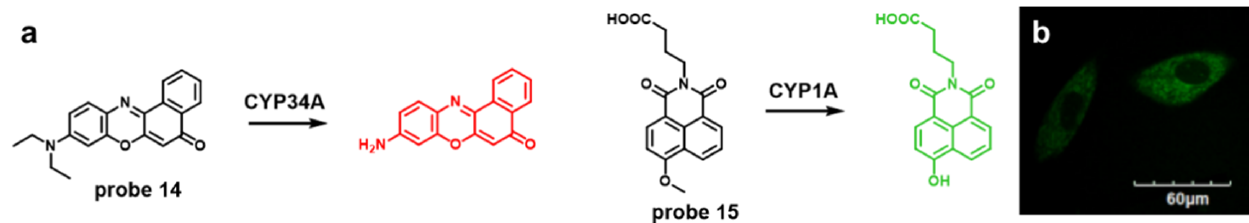
Figure 4. Chemical structures of probes 12 and 13 .